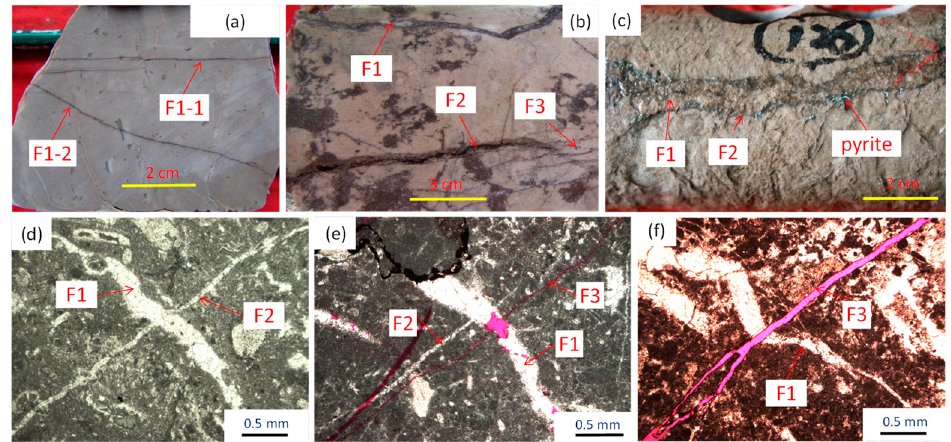
Figure 7. Photographs and photomicrographs showing fractures in the cores ( a–c ) and thin sections ( d–f ) of the Ordovician carbonates in the Halahatang area. ( a ) One vertical fracture (F1-1) and one high angle fracture (F1-2) showing a narrow aperture and cements filling, H902, 6632.12 m; ( b ) high angle fractures infilled by calcite cements (F1), reactivated open fracture filled with bitumen (F2) and late subparallel fractures at the tip (F3), H601-1, 6634.40 m; ( c ) an early cemented fracture (F1) reactivated (F2) along the fracture wall and splits the argillaceous and pyrite cements, X101, 6767.52 m; ( d ) an early wider, enlarged fracture (F1) terminated a late narrower fracture (F2), H11-1, 6682.5 m; ( e ) cross-cutting relationship showing early wide fracture (F1) terminated the second generation fracture (F2), and cut across by the latest open fracture (F3), J7, 7108.6 m; ( f ) late open fracture (F3) cuts across the former earlier, fully infilled fracture (F1), X7, 6918.12 m.